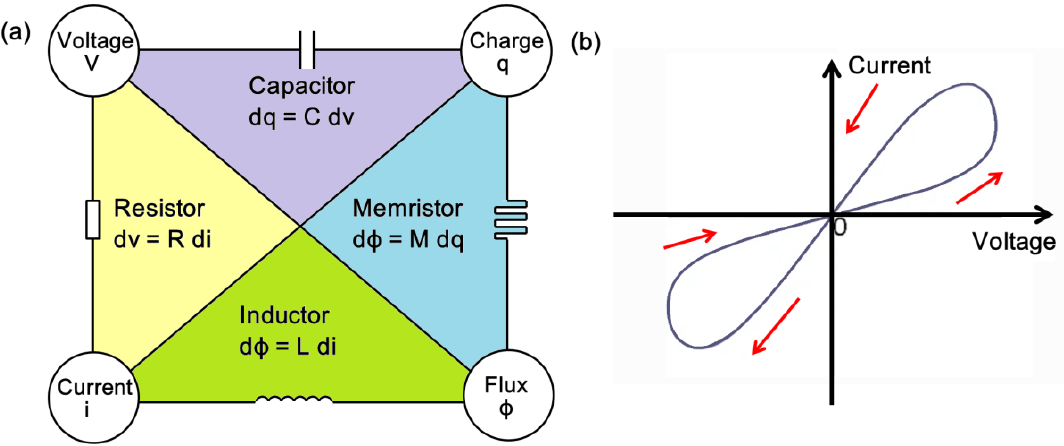
Figure 10. PCRAM-based logic operations: ( a ) measuring the applied voltage and voltage across the cell during initialization and computing for the four cases for logic inputs X 1 and X 2 ; ( b ) cell resistance with respect to the pulse sequence for NOR and NAND operations, respectively; ( c ) the AND setup and its corresponding voltage output. (( a ) is reprinted with permission from [120]; ( b ) is reprinted with permission from [121]; ( c ) is reprinted with permission from [122].)